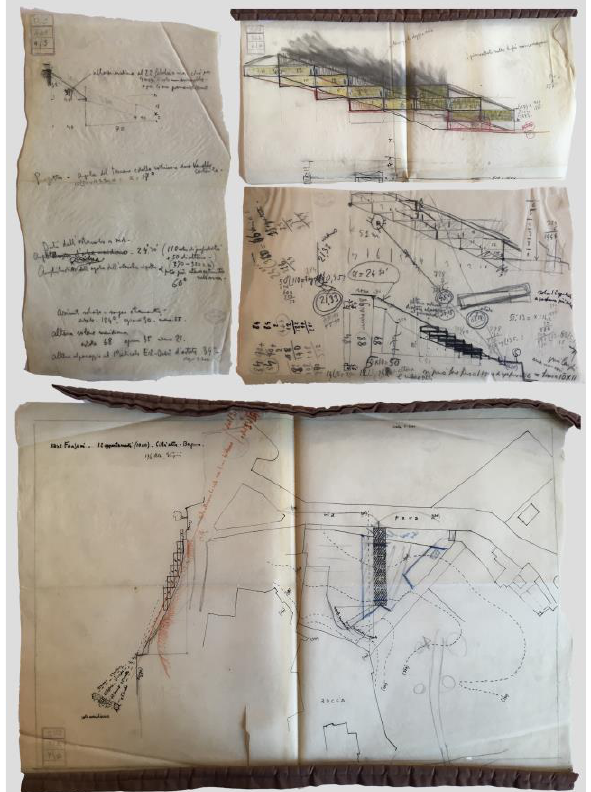
Figure 5. The planivolumetric study that indicates particular attention of the architect to the choice of the optimal positioning of the apartments operated through careful calculations of the altitude of the sun at the summer and winter solstices.